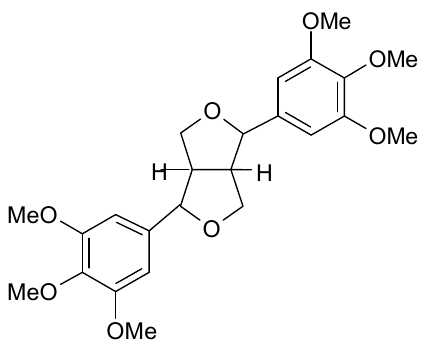
Figure 1. Chemical structure of